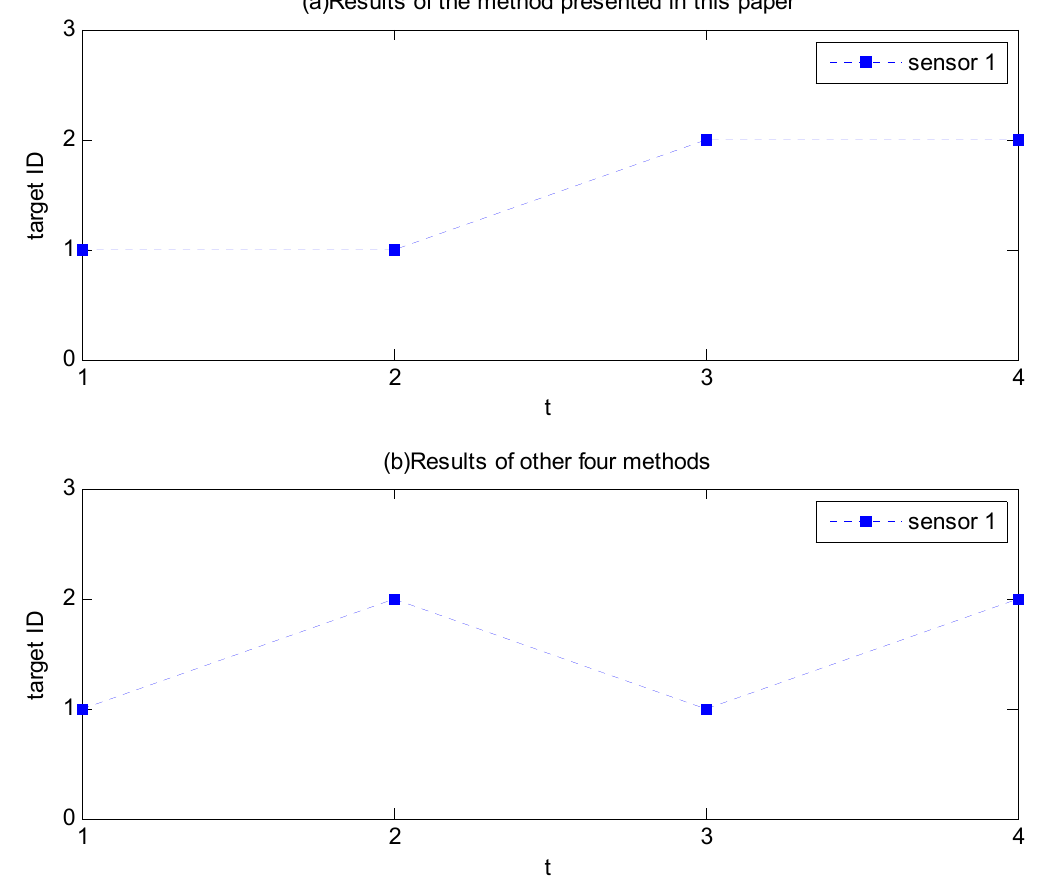
Figure 4. Processing of sensor recognition of 2 targets in scenario 1.